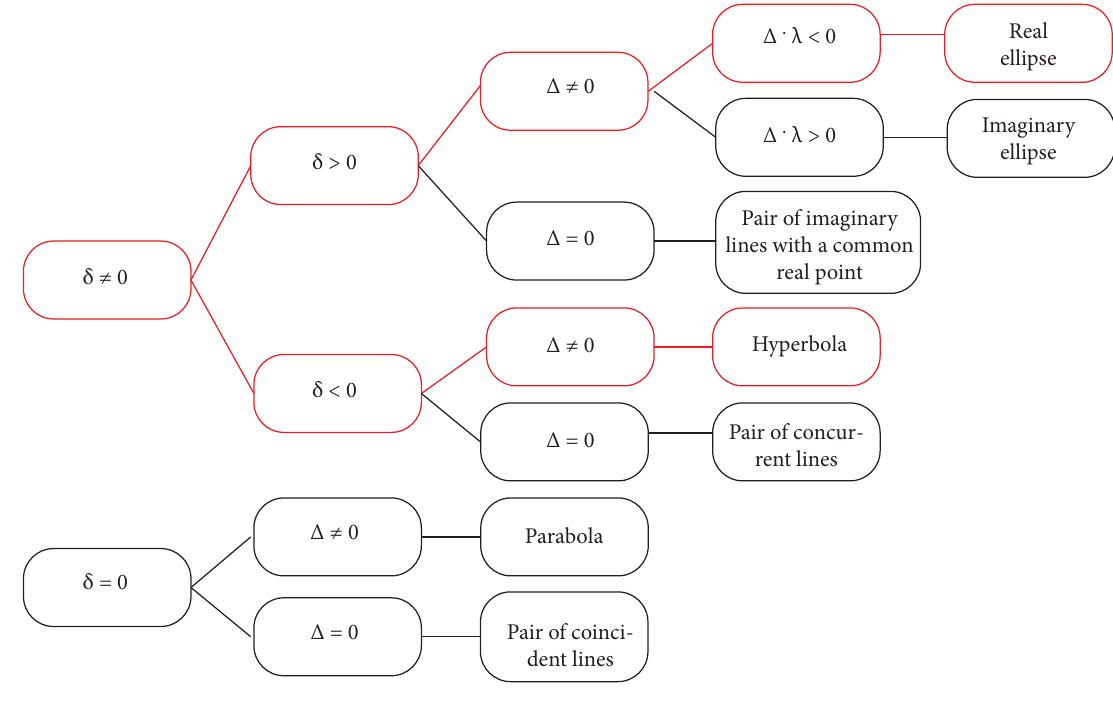
Figure 3. Curve types obtained according to the invariant’s